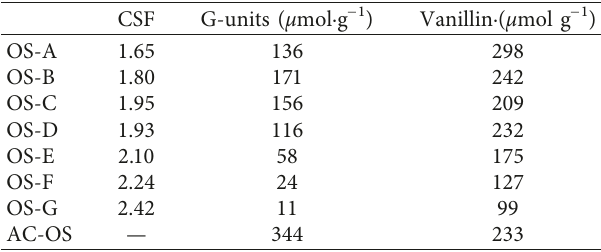
Table 5: Yields from thioacidolysis and GC-MS of the thioethy- lated guaiacyl (G) monomer derivatives (mean of two independent analyses).